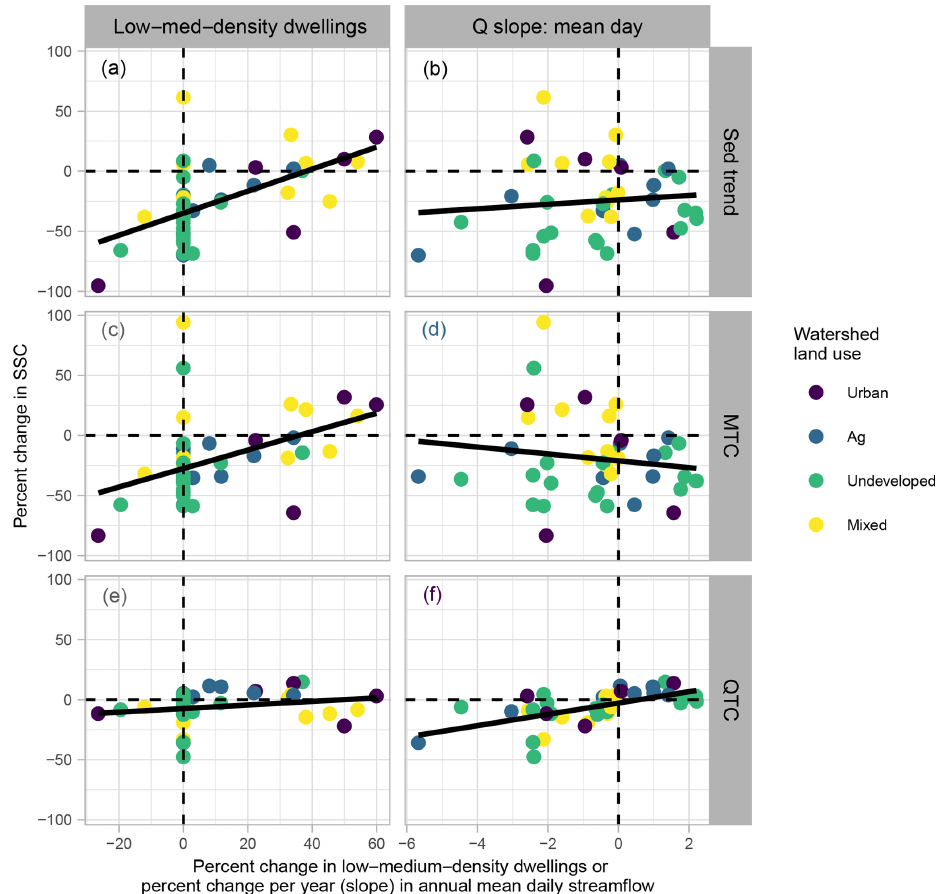
Figure 6. Bivariate plots of the SSC trend, MTC and QTC versus two potential causal variables: percent change in low–medium-density dwellings in the watershed and percent change per year (slope) of annual mean daily streamflow for the 1992–2012 trend period. Black line is an ordinary least-squares regression fit through all the data to show relationship between variables, and dashed lines indicate 0% change. Sed: